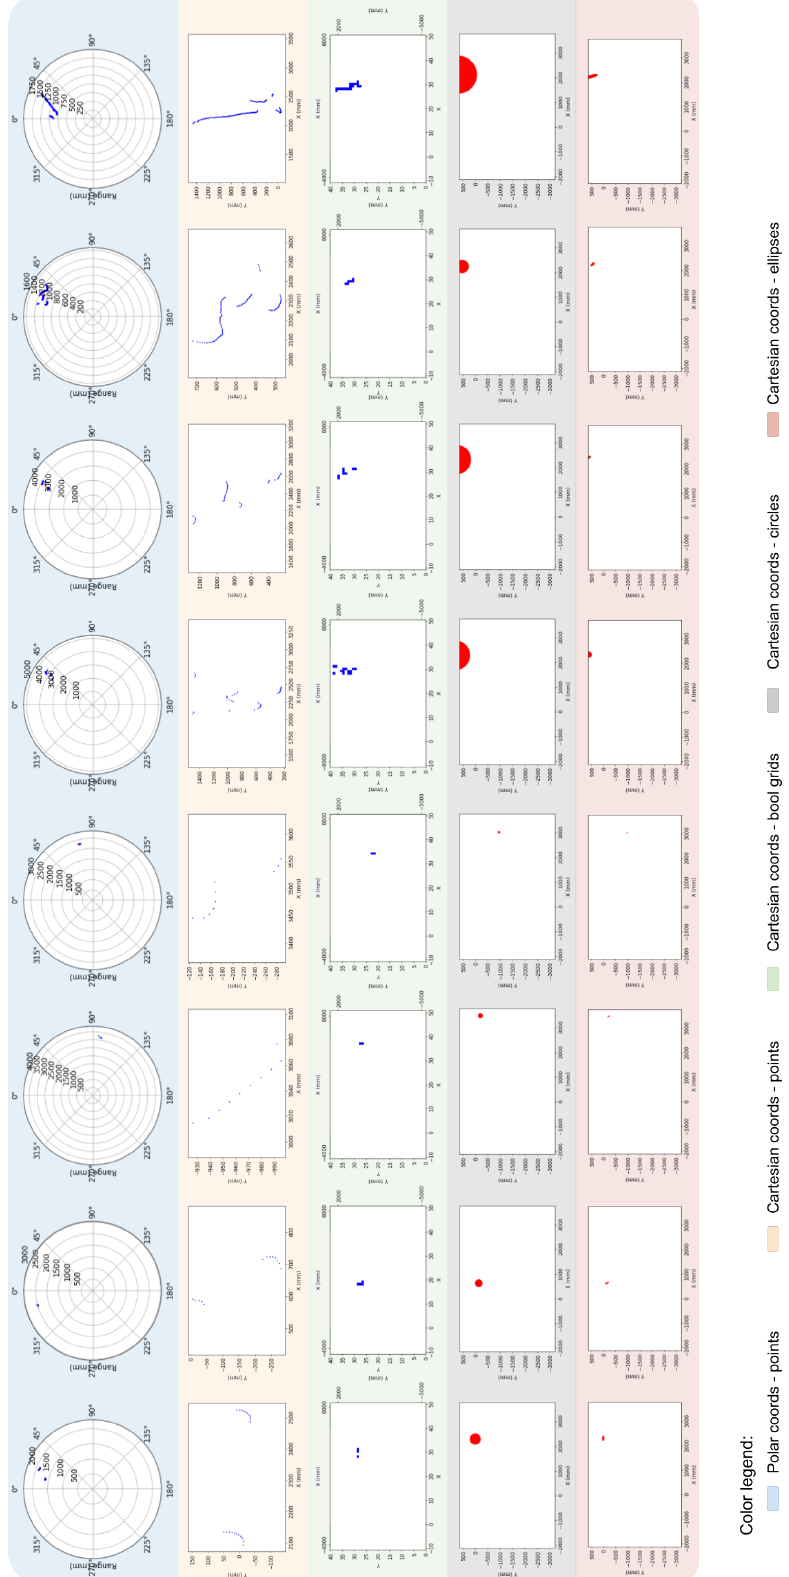
Figure 7. An example of data acquisition and transformation using our proposed